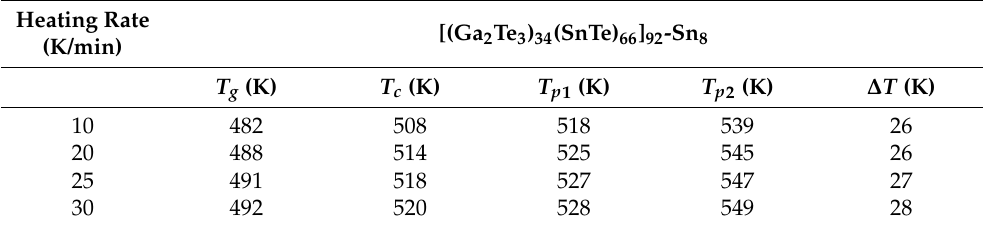
Table 2. The values of T g , T c , T p 1 , T p 2 and Δ T for S8 amorphous sample at different heating rates.